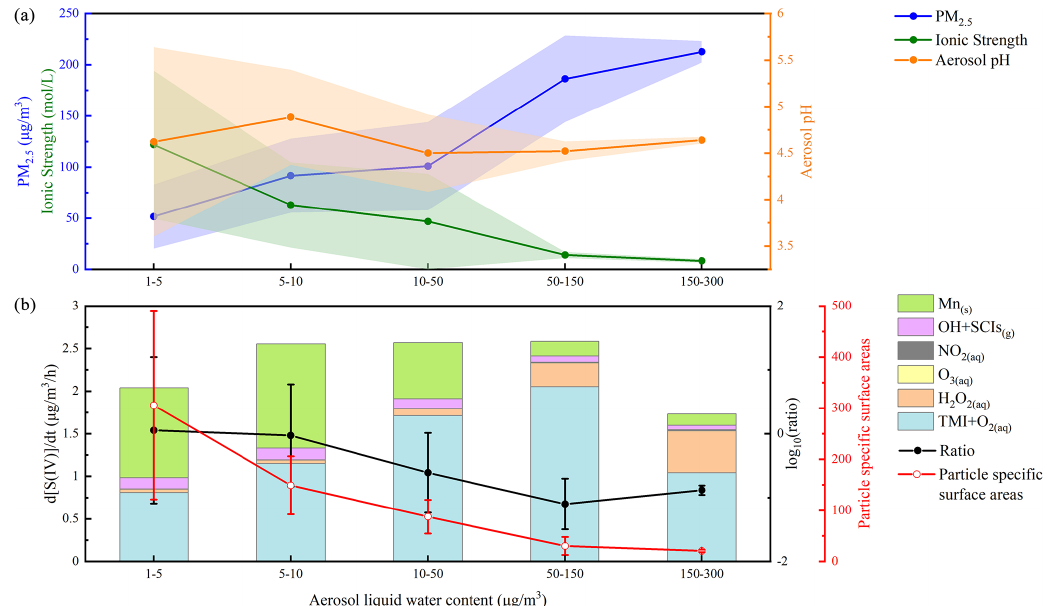
Figure 3. Variation in PM 2 . 5 , ionic strength, aerosol pH, particle-specific surface areas and sulfate formation rates from different pathways with aerosol liquid water content (ALWC) during the winter field campaign. The total number of valid data points shown in the figure is 479. The shaded area refers to the error bar ( ± 1 σ ) of PM 2 . 5 mass concentration, aerosol ionic strength and pH calculated by ISORROPIA II (Fountoukis and Nenes, 2007). The ratio in (b) refers to the ratio of contributions from Mn-surface to the aqTMI to produce sulfate. Particle- specific surface areas represent the ratio of particle surface area (µm 2 / cm 3 ) to mass concentration (µg / m 3 ).